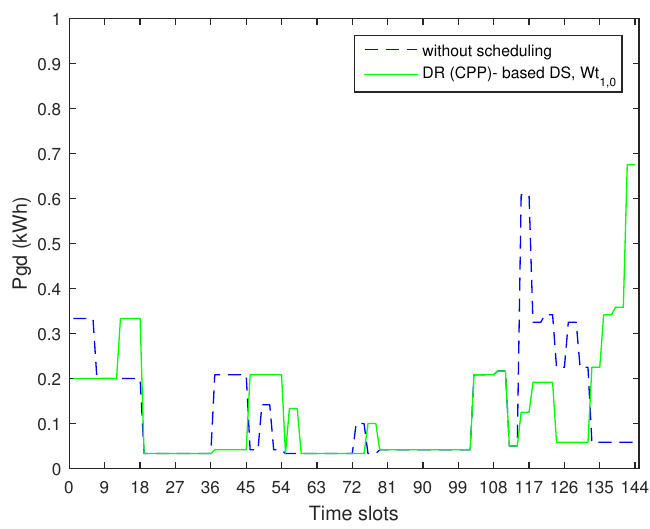
Figure 15. Load profile with maximal reduction in CE for CPP (DS).